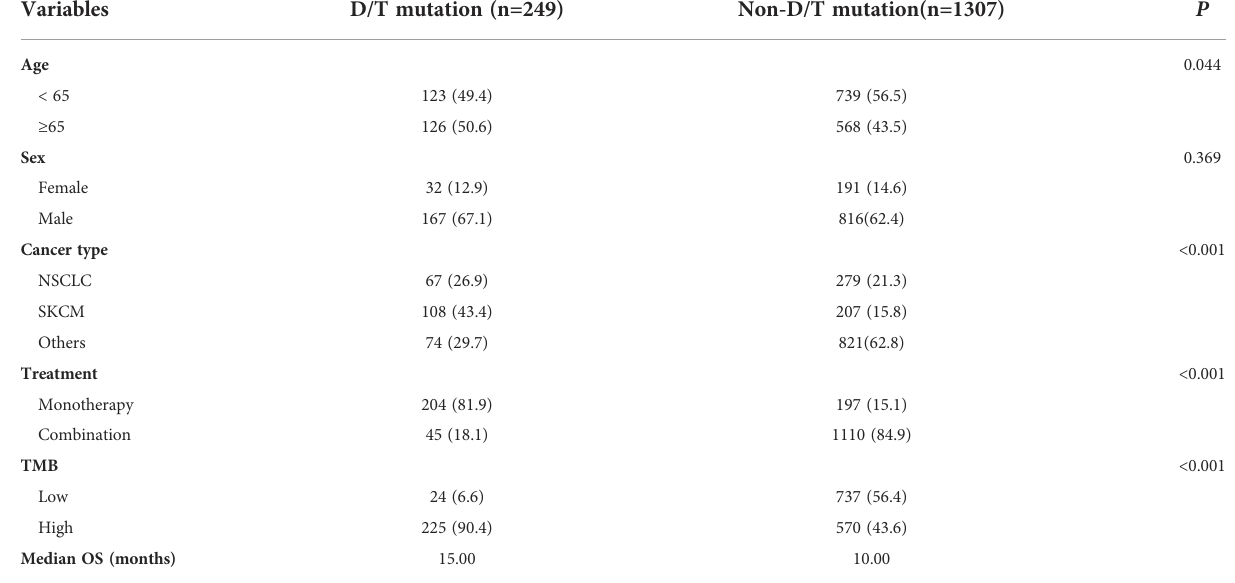
TABLE 1 Relationship between PTPRD/PTPRT mutation and clinicopathological characteristics in ICI-treared cohort (Samstein et al.).